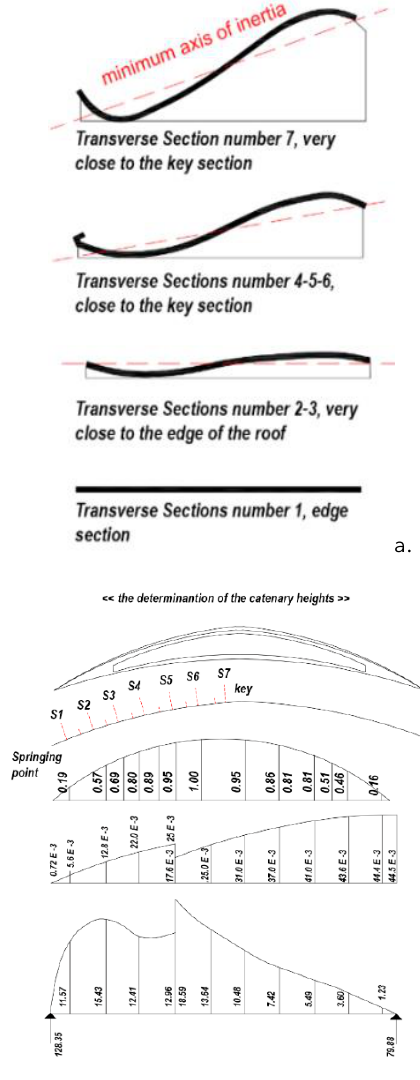
Figure 3: the two major steps from Eladio Dieste’s calculation methods are (a.) the adaptation the transverse section to its minimum axis of inertia, and (b.) the adjustment of the longitudinal section heights with diagrams of bending moments and force.